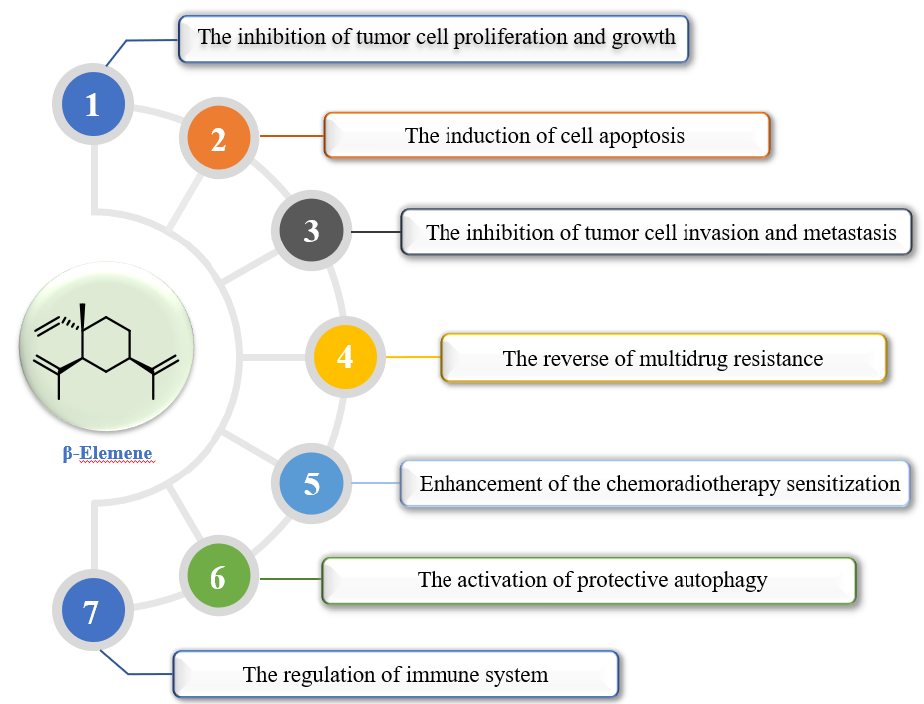
Figure 2. Summary of the potential anti-tumor mechanisms of β -elemene.